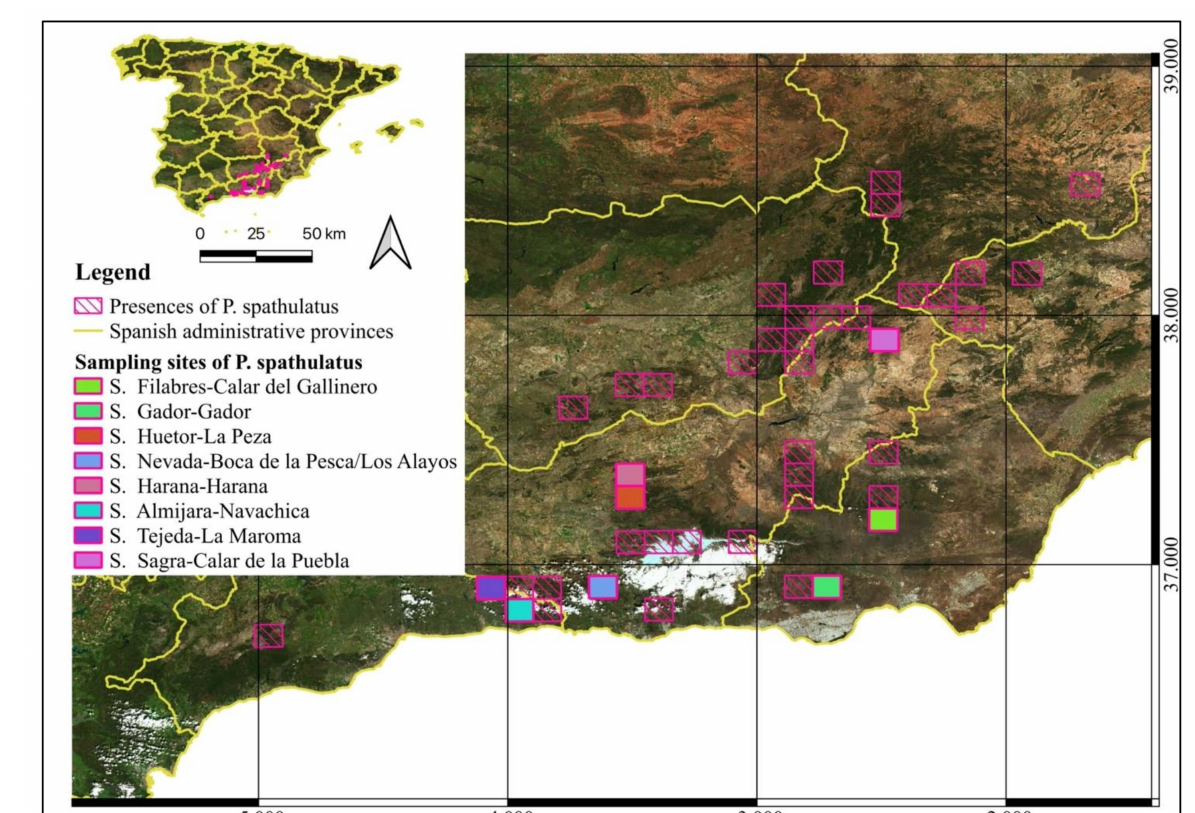
Figure 3. Location of the study area and sampling sites of P. spathulatus , pink grids indicate the presence of this species and solid-coloured grids the sampling